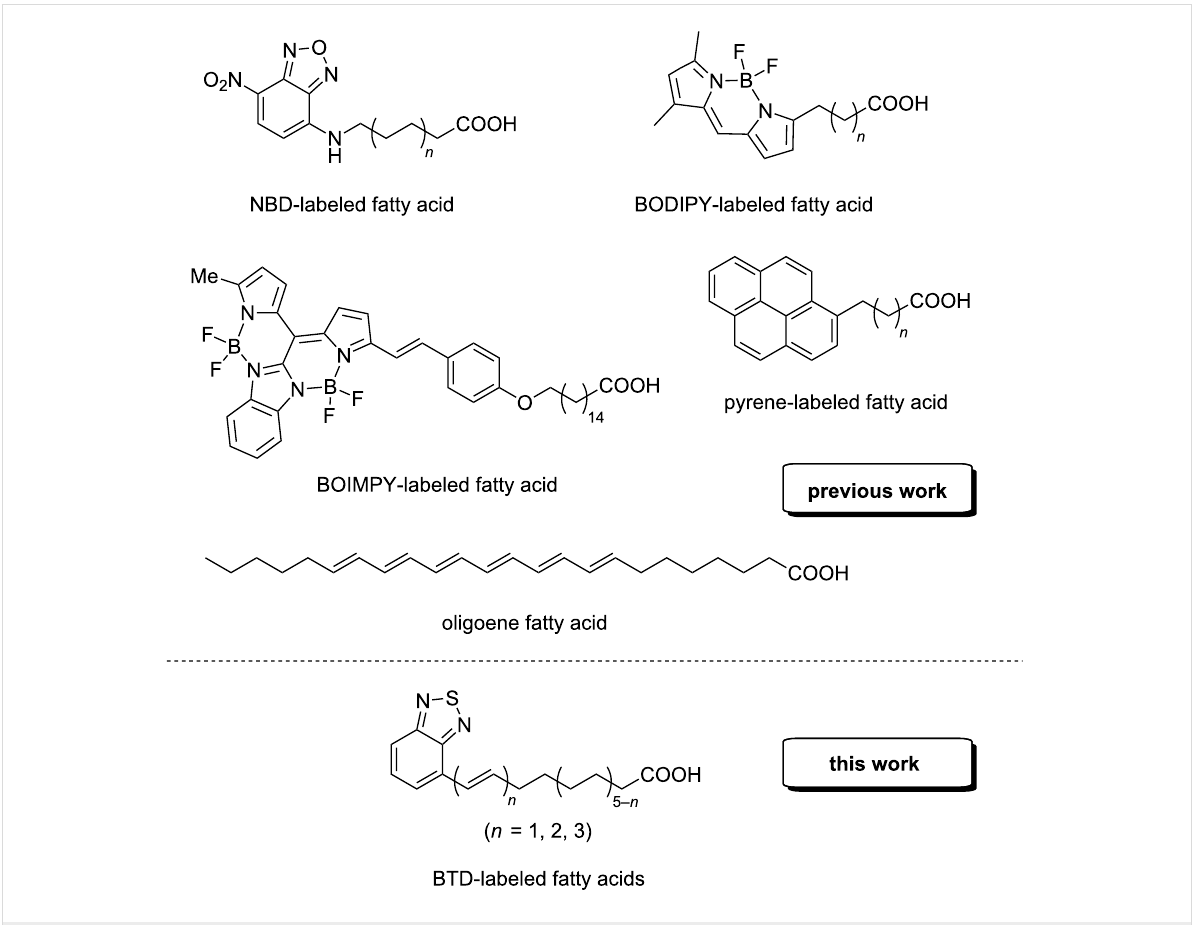
Figure 1: Examples for previously prepared fluorescent fatty acids and our present